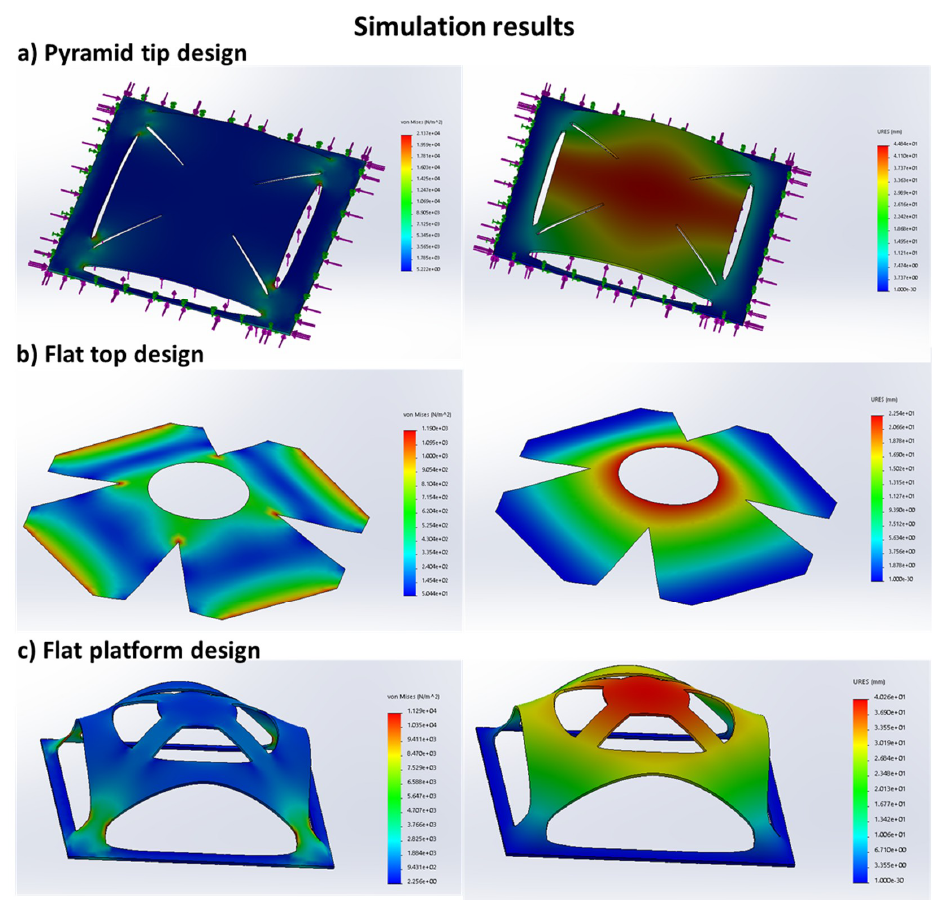
Figure 4. SolidWorks simulation results showing the stress ( left ) and strain ( right ) analysis of ( a ) the pyramidal tip; ( b ) flat-top; and ( c ) flat platform kirigami design patterns. The pyramidal tip design has